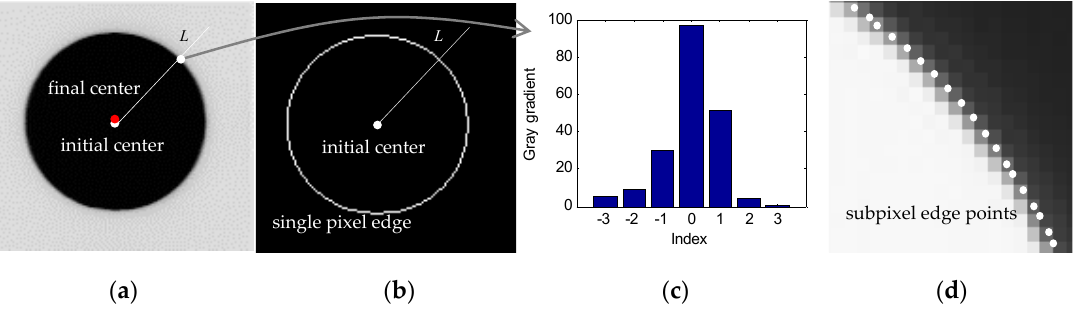
Figure 7. Subpixel extraction of the featured hole center: ( a ) Original image; ( b ) Single pixel edge; ( c ) Gray gradient; ( d ) Subpiexl edge points.